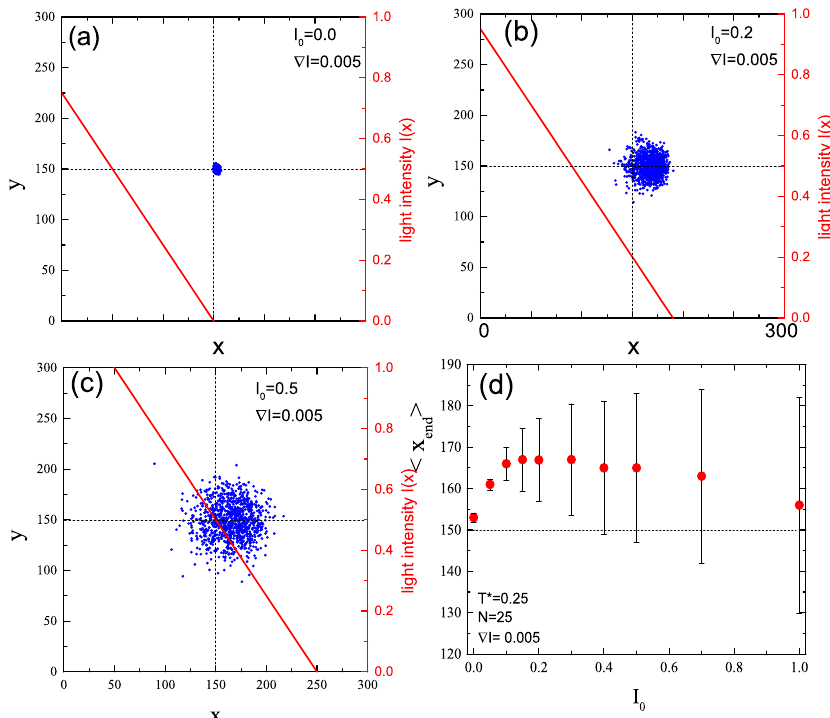
Figure 8. Projections of CM of 10 3 chains onto x − y plane at the end of the simulation for constant value ∇ I = 0.005 and I 0 = 0 ( a ), I 0 = 0.2 ( b ), and I 0 = 0.5 ( c ). Red lines are plots of I ( x ) , Equation (3) (right axis). Averaged displacement of CM of chains in x direction and its standard deviation as a function of I 0 ( d ).